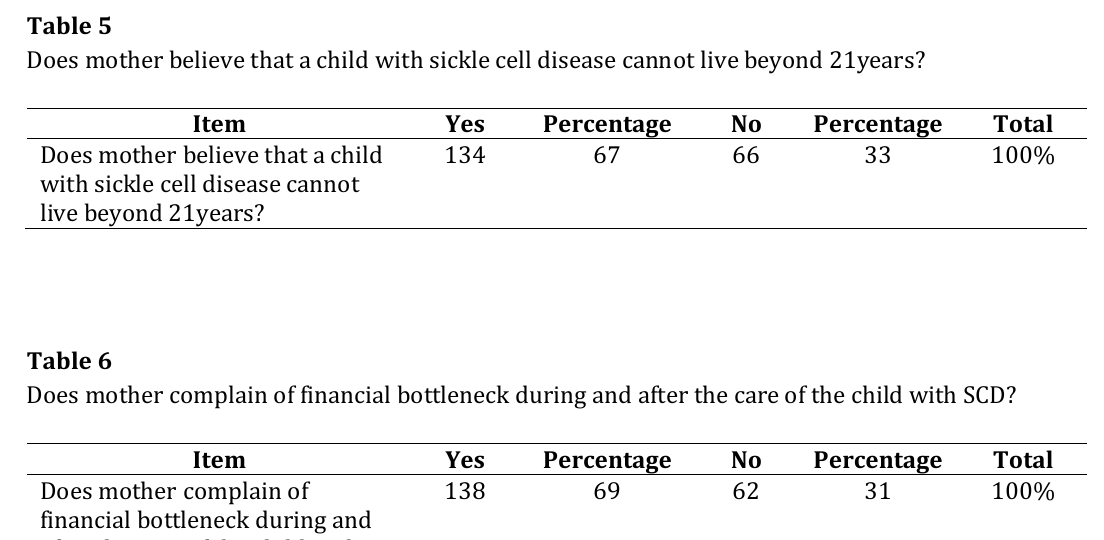
Item Mother complained of family abandonment and neglect during the care of the child